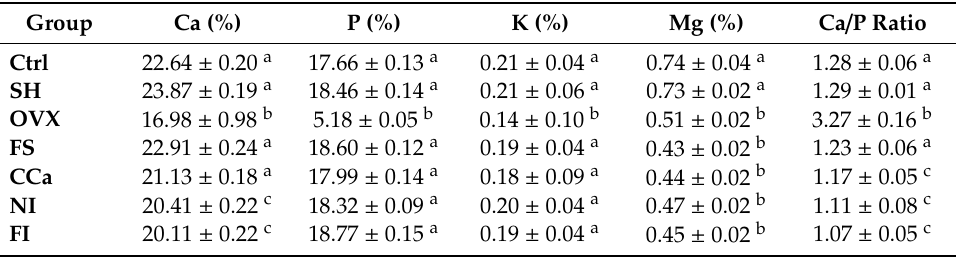
Table 4. Mineral content in femoral bone of rats fed with the experimental